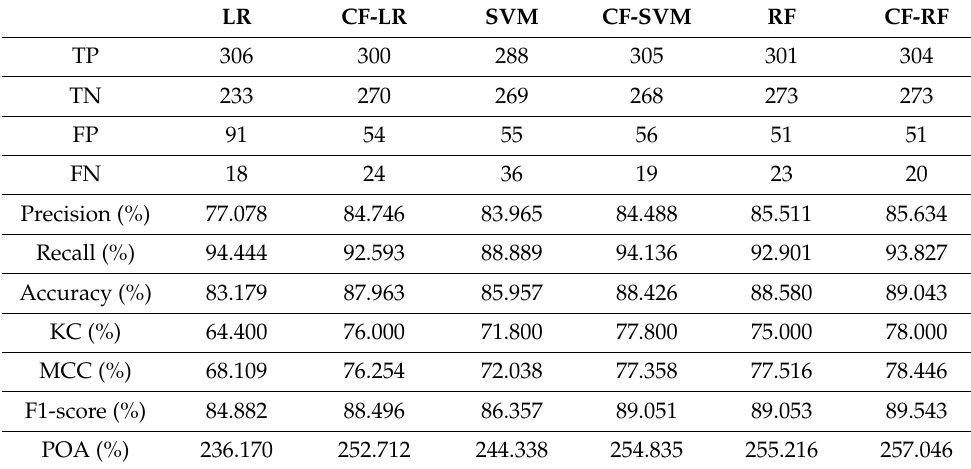
Table 9. Analysis of prediction ability of different models by validation